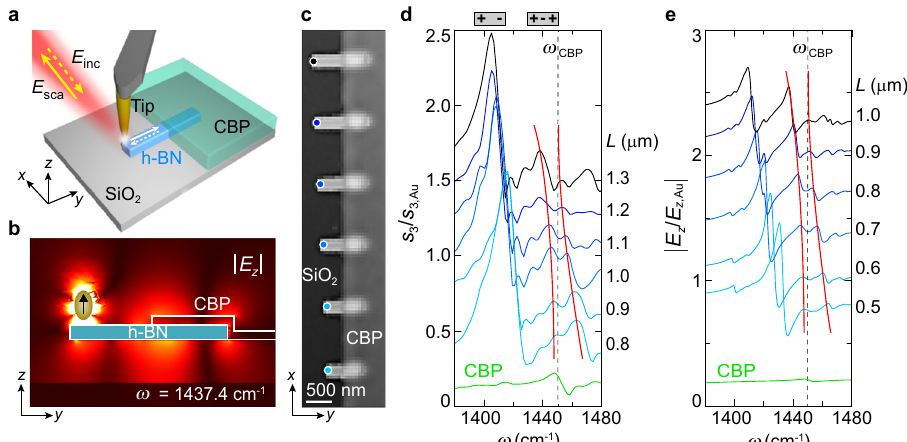
Fig. 1 | Tip-enhanced near- fi eld probing of half molecule-covered h-BN nanor- esonators. a Illustration of the experiment. b Numerical simulation of the electric fi eld distribution at ω = 1437.4cm − 1 around an h-BN nanorod of 1000nm length, 250nm width and 87nm height, whose right half is covered by a 50nm thick CBP layer. The vertical arrow indicates a point-dipole source mimicking the tip. c Topography image of h-BN nanorods (length L , 87nm height and 250nm width) that are half covered by a 50nm thick CBP layer. d Experimental nano-FTIR amplitude spectra recorded at the positions marked in panel c by dots of the respectivecolor.Forbettervisualization,spectrafor L =1.0and1.3 μ marescaledby afactorof 0.7. e Simulated nano-FTIRamplitudespectra,asexplainedinFig.3.For thewidthandthicknessoftheh-BNrodsweusedthenominalexperimentalvalues. The lengths L were chosen such that the second-order FP mode tunes across the molecular vibrational resonance of the CBP molecules at ω = 1450cm − 1 . We attri- bute thedifferencesbetween L inthe experimentand thesimulation tofabrication